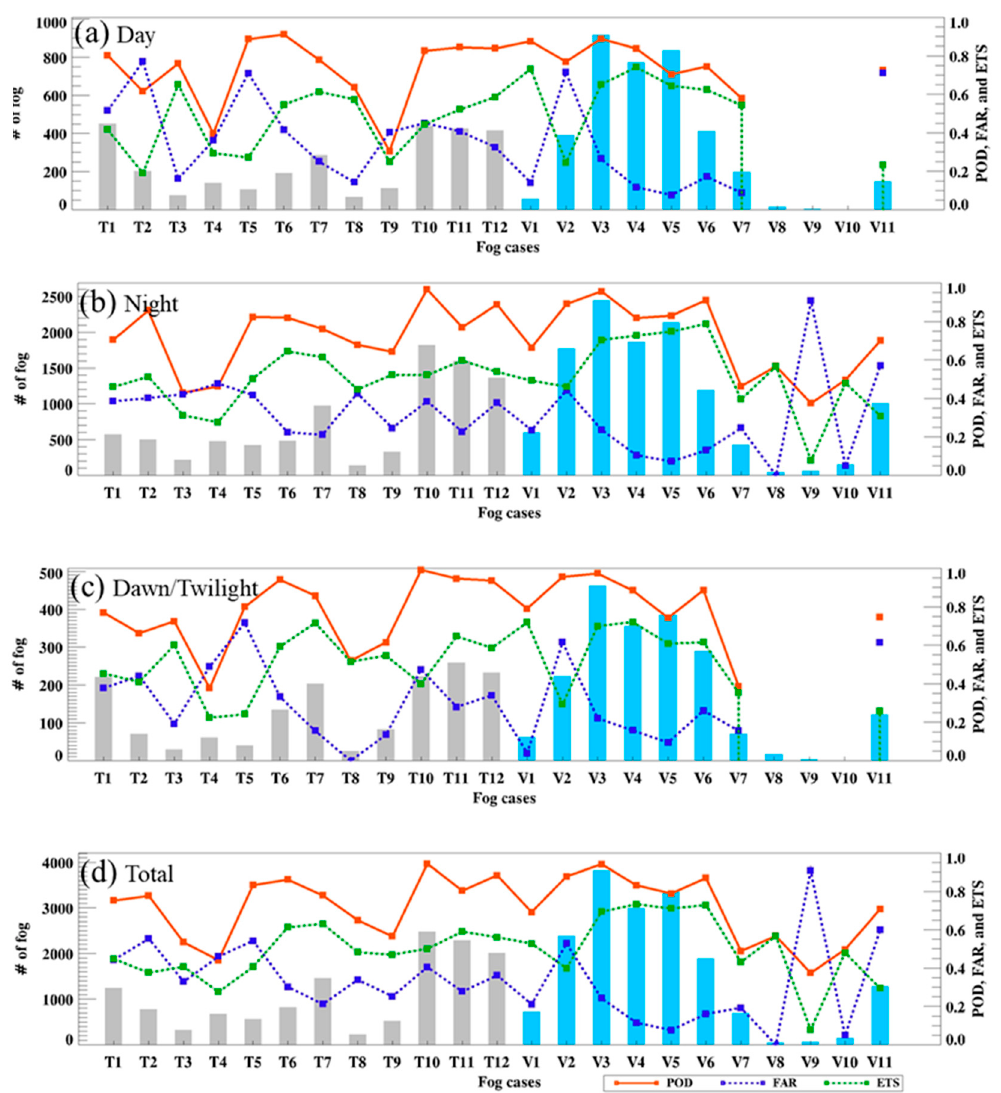
Figure 11. Validation results for the training (T) and validation cases (V) with ground-observed visibility data according to the time (( a ) day, ( b ) night, ( c ) dawn / twilight, and ( d ) total). Red, blue, and green lines with dots indicate POD, FAR, and ETS for each fog case, respectively. The bars represent the total number of fog points used for validation. The gray and blue bar graphs are used to distinguish between training and validation cases.